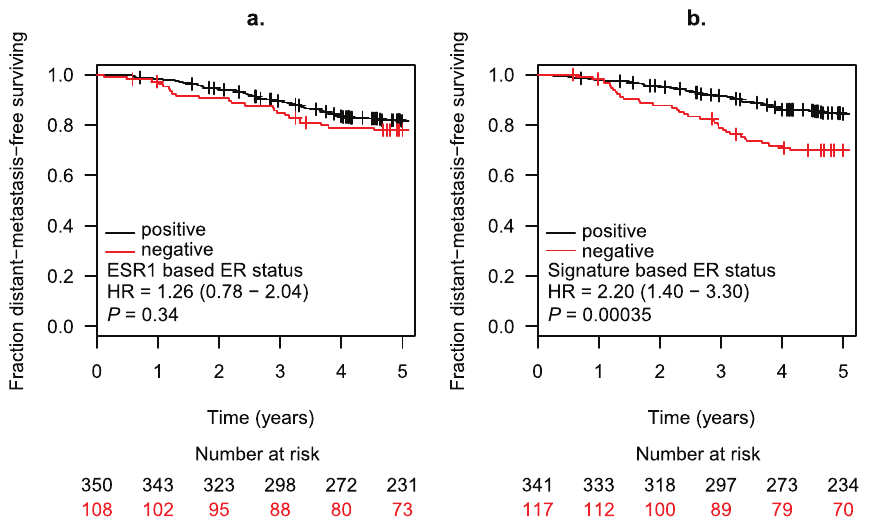
Figure 4. Expression-based ER classifiers predict distant-metastases-free survival of IHC ER positive patients treated with tamoxifen. (a.) ESR1 expression based ER status; (b.) 23-gene signature based ER status. follow a bimodal distribution in DFCI data set (left) and the inferred cutoff value based on the bimodal distribution is highly consistent with ER status determined by IHC (right).